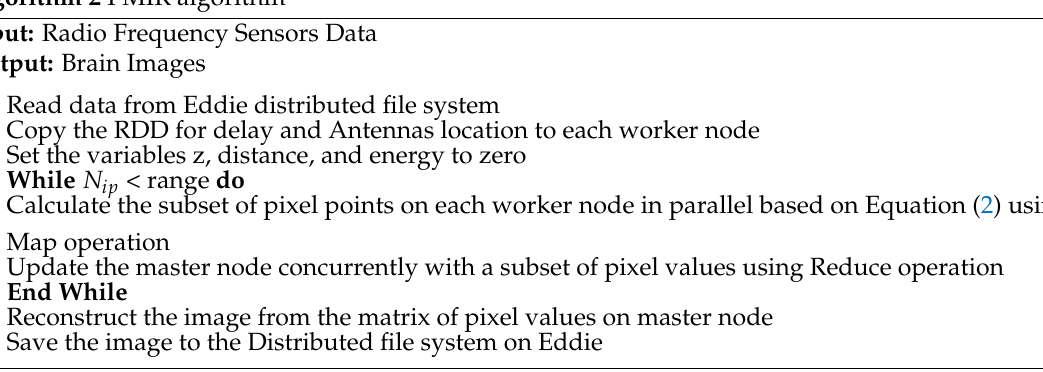
Algorithm 2 PMIR algorithm